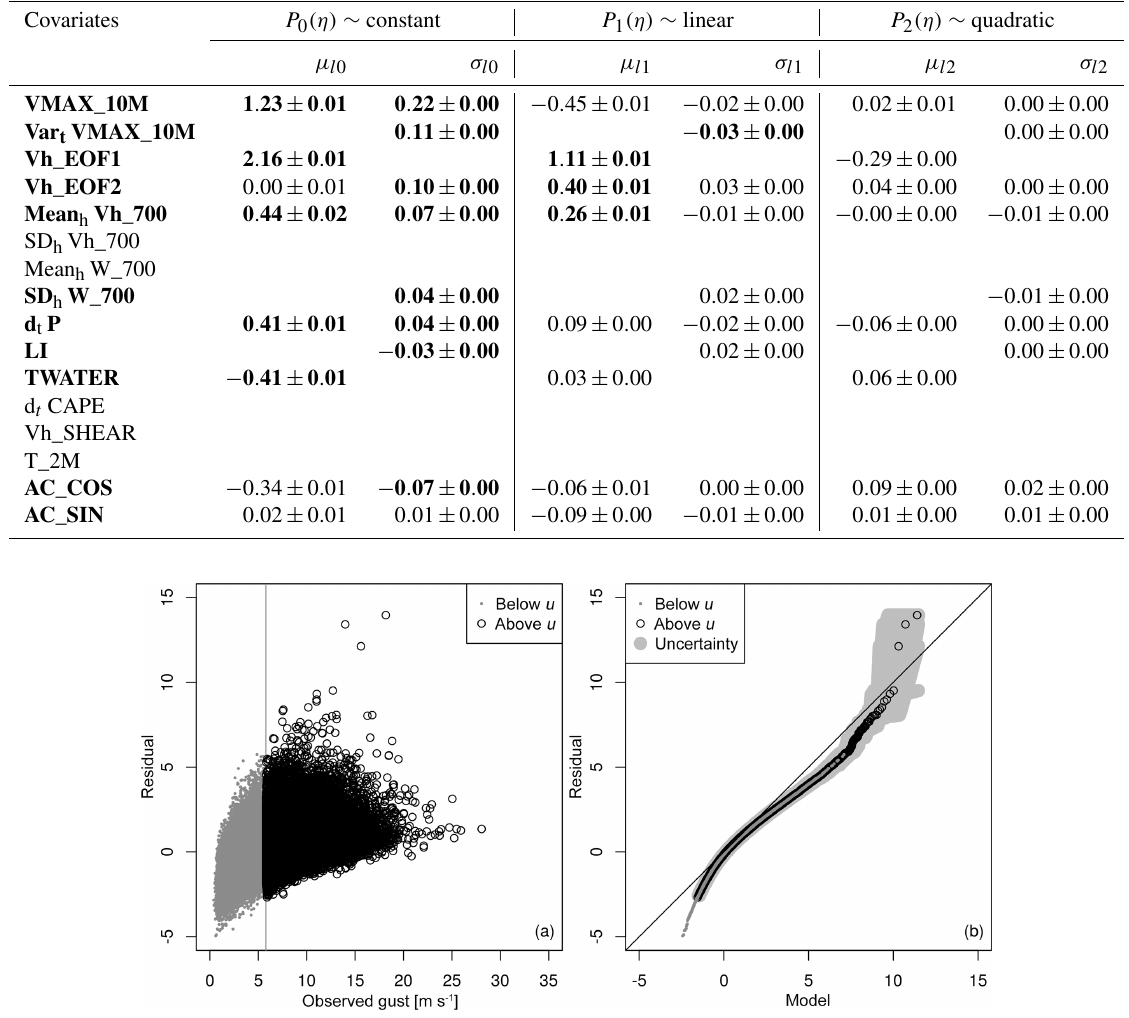
Figure 2. Diagnostics for Legendre model without VAR t VMAX_10M and with a threshold of u = 5 . 79ms − 1 at 10m: (a) scatter plot of the standard Gumbel residual against observed gusts, and (b) Q – Q plot of the residuals against the standard model. Uncertainty is given in light grey as the range of a 100-member bootstrap sample generated with blocks of 10 consecutive